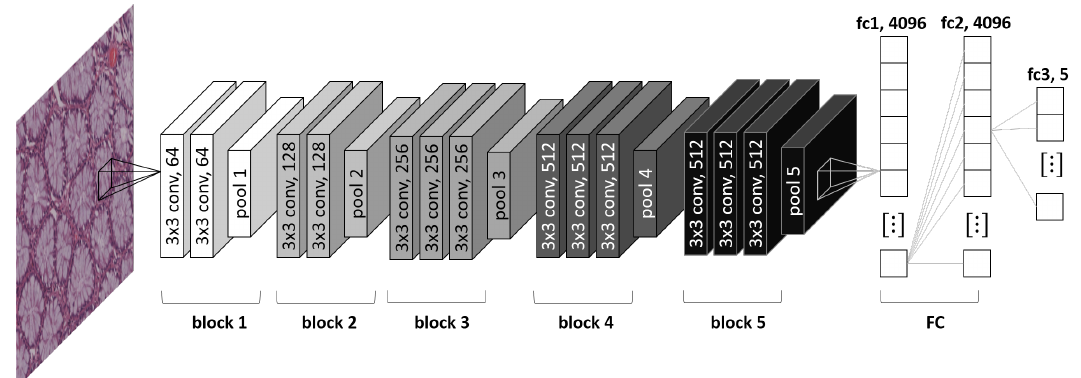
Figure 4. Architectural representation of the VGG-16 deep network used for transfer learning (main building